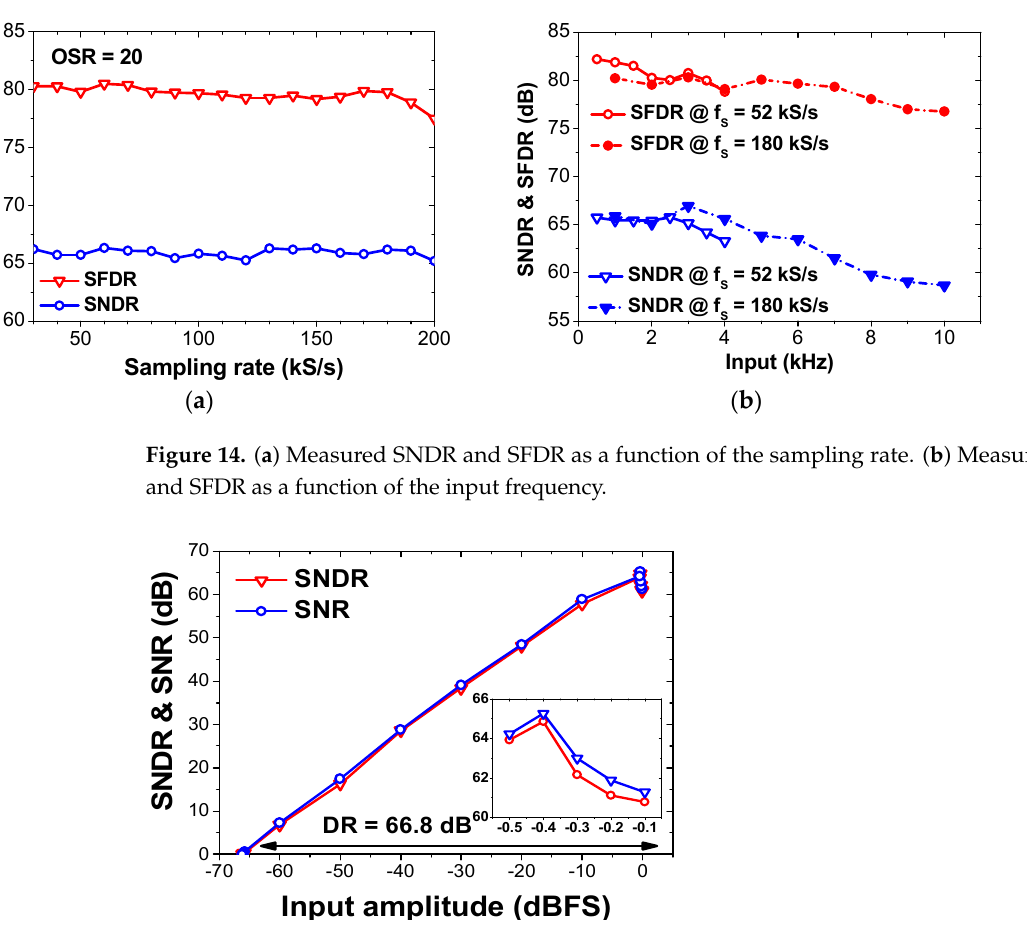
Figure 13. Measured output spectrum of the ADC. ( a ) f in = 1.33 kHz and f S = 52 kS/s and ( b ) f in = 8 kHz and f S = 180 kS/s.